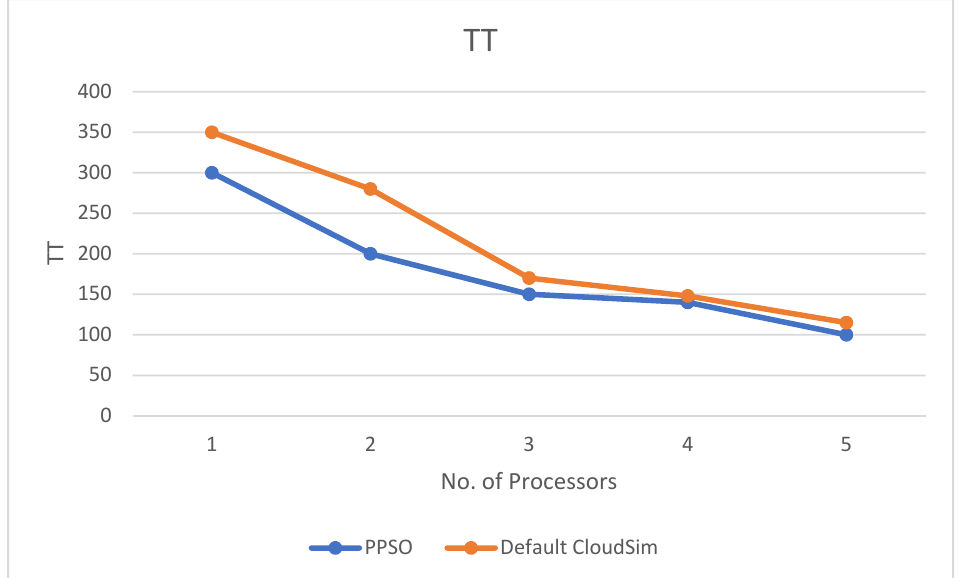
Figure 5. The relation between TT and number of processors.